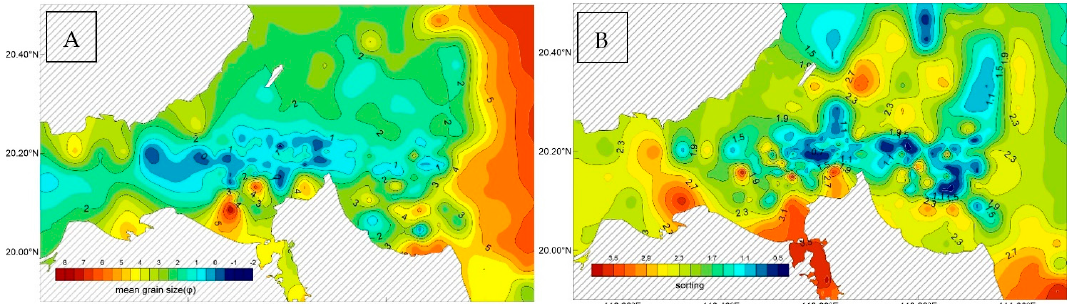
Figure 3. Distribution of grain size parameters, ( A ) mean grain size contours with an interval of 0.5 phi, ( B ) sorting contours with an interval of 0.2.